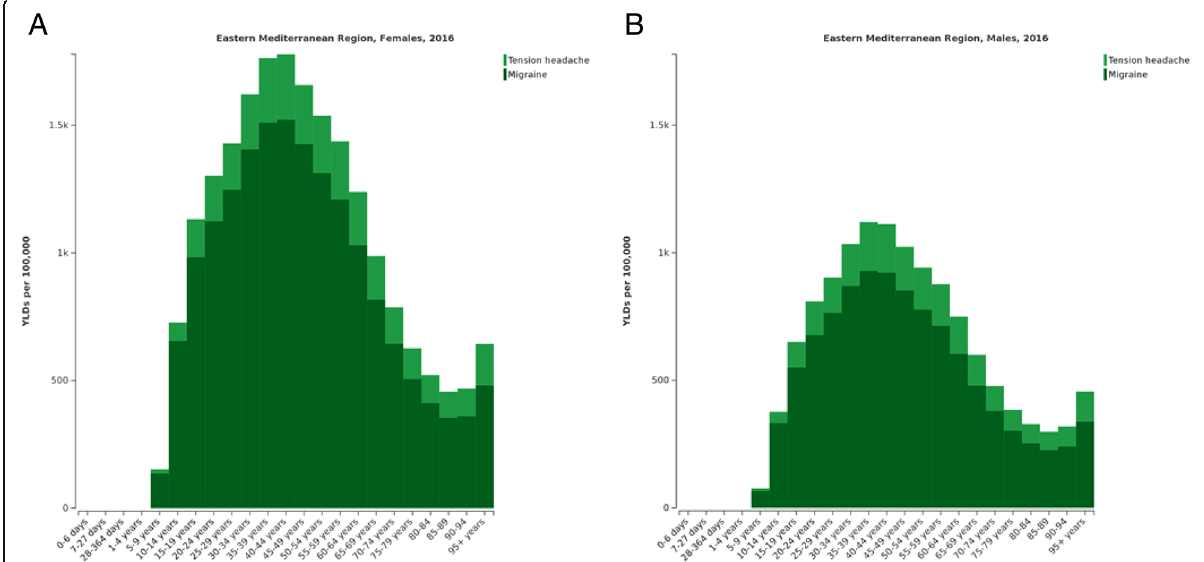
Fig. 2 YLD rates of migraine and TTH by age in EMR for females ( a ) and males ( b ) in 2016. Abbreviations: TTH, tension-type headache; EMR, Eastern Mediterranean